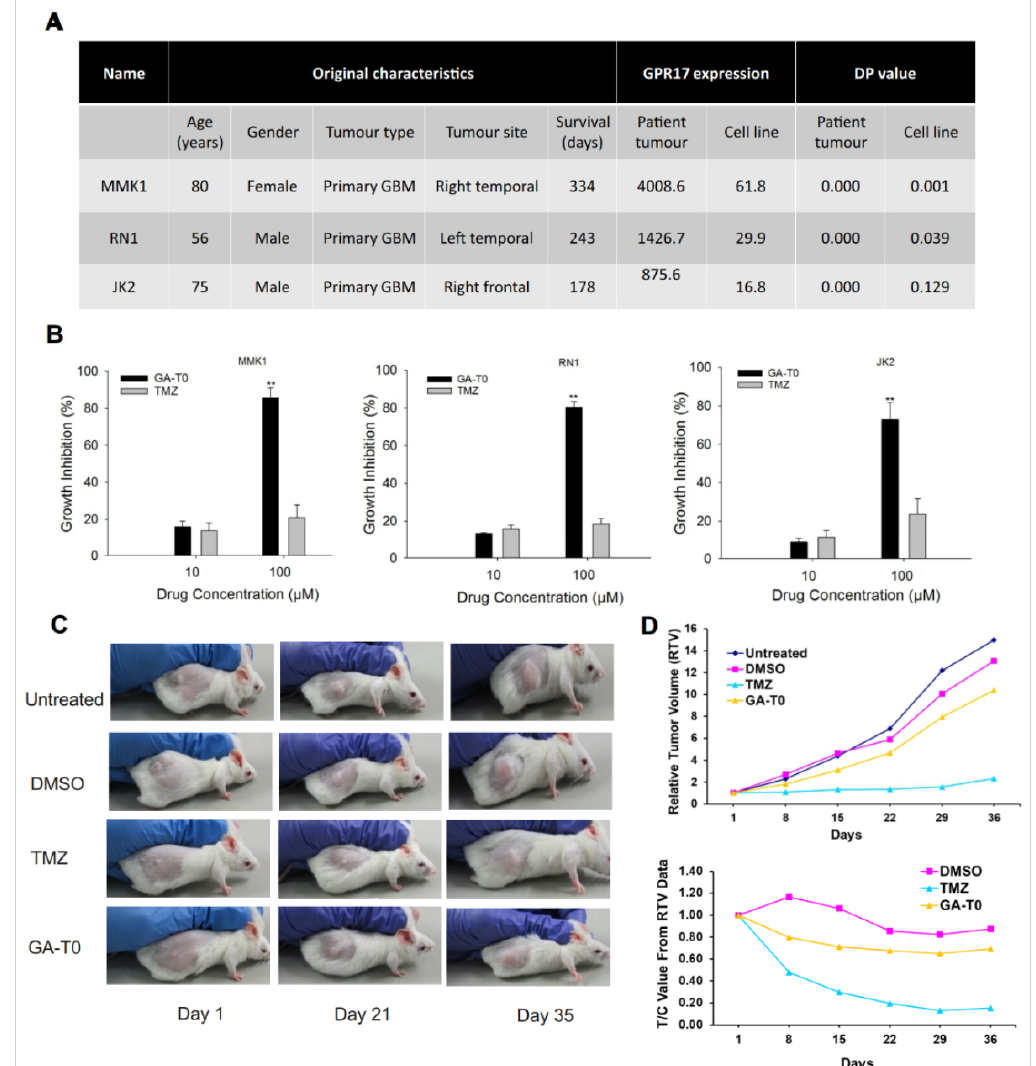
Figure 6. The anti-tumor effect of GA-T0 on patient-tissue-derived GBM cells and PDX animal models. ( A ) Demo- graphic features of MMK1, RN1, and JK2 cells derived from GBM patients showing differential GPR17 expression. ( B ) Percentage of growth inhibition on patient-tissue-derived GBM cell lines upon treatment with 10 and 100 µ M of GA-T0 and TMZ. ( C ) Images of xenograft GBM treated with DMSO (vector control), TMZ (positive control), and GA-T0 (Drug) at Day 1, Day 21, and Day 35. ( D ) Periodical validation of the relative tumor volume (RTV) and relative activity criteria (T/C) in PDX models on treatment with DMSO, TMZ, and GA-T0. ( A ) DP—detection p -value. Illumina beadchips allow a detection p -value to be calculated as an estimate of gene measurements relative to background. p < 0.05 for all samples on a beadchip for a given probe was used as a cut off to compile the gene expression datasets. ( B ) The results are presented as the mean values ± SEM of six experiments; significant data are denoted by asterisks (*, p < 0.05; **, p <